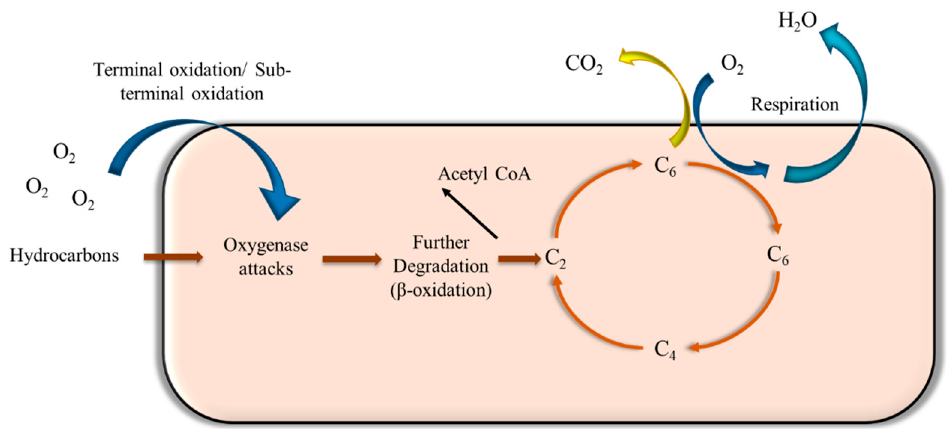
Figure 4. The principle behind aerobic hydrocarbon degradation by microbes